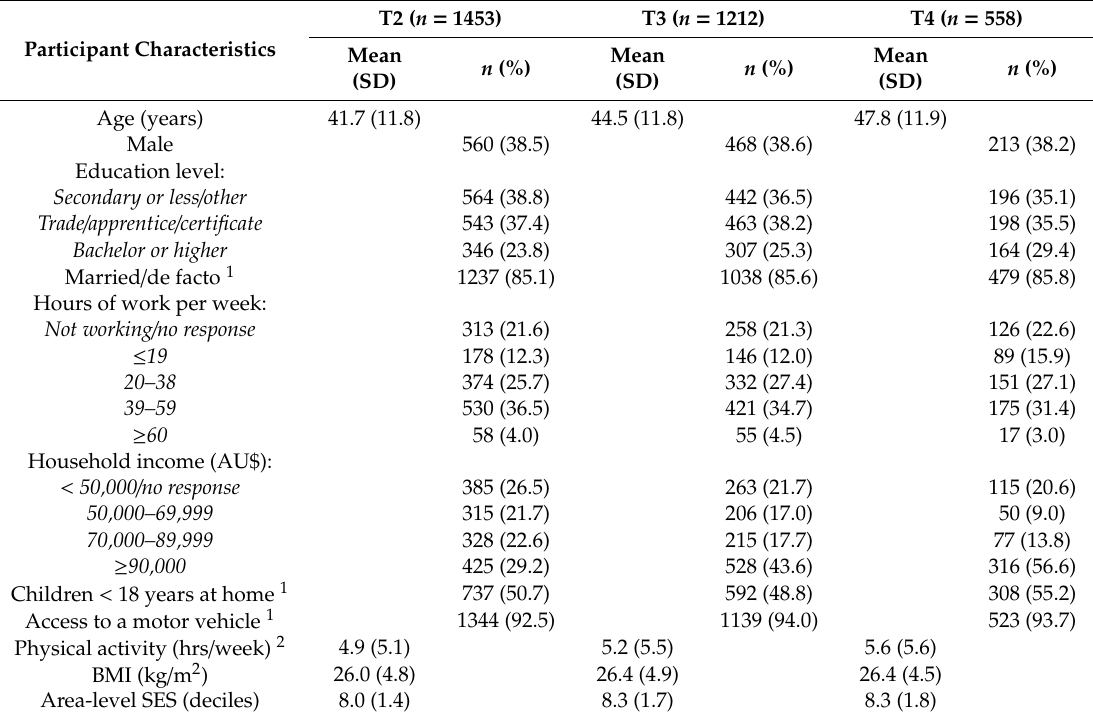
Table 1. Summary statistics of participant